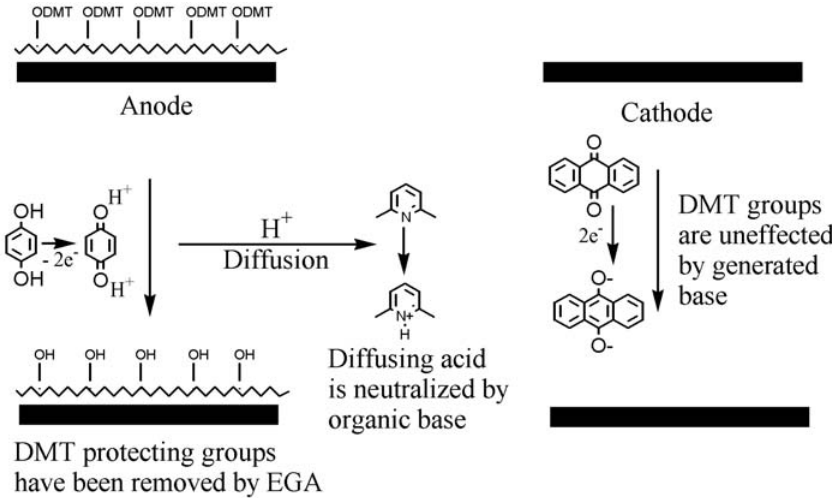
Figure 2. EGA Reation Scheme